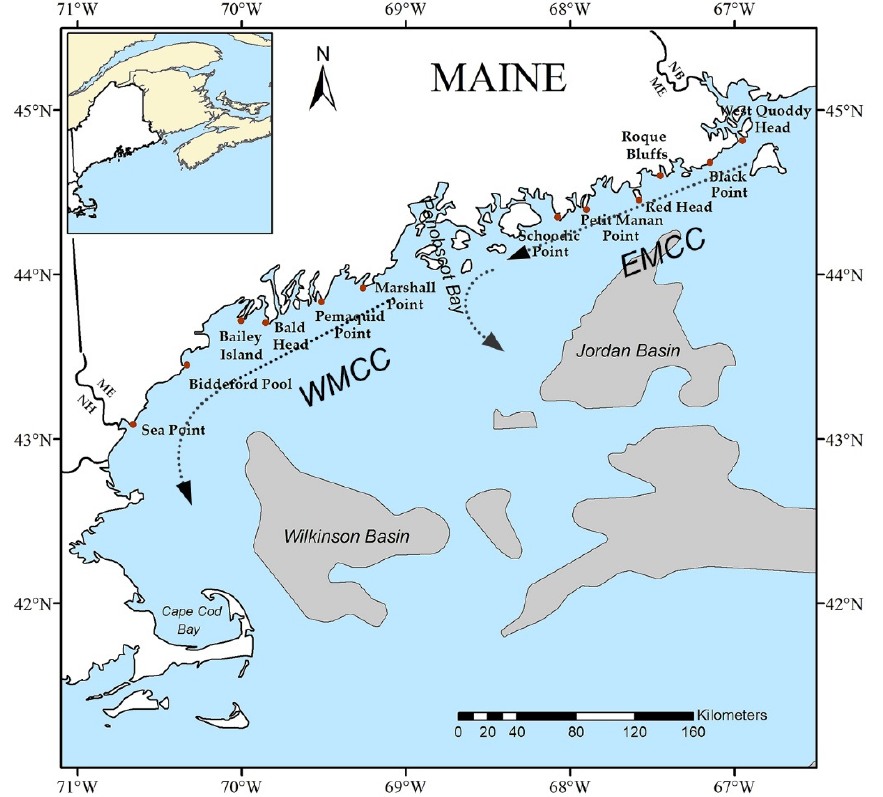
Figure 1. The Gulf of Maine with survey locations, geographic features, 200 m bathymetric contour and generalized flow of the principal segments of the Gulf of Maine Coastal Current, the Eastern Maine Coastal Current (EMCC), and Western Maine Coastal Current (WMCC). Inset for context with the northeastern US (white) and Canada. Abbreviations: NH, New Hampshire; ME, Maine; NB, New Brunswick.